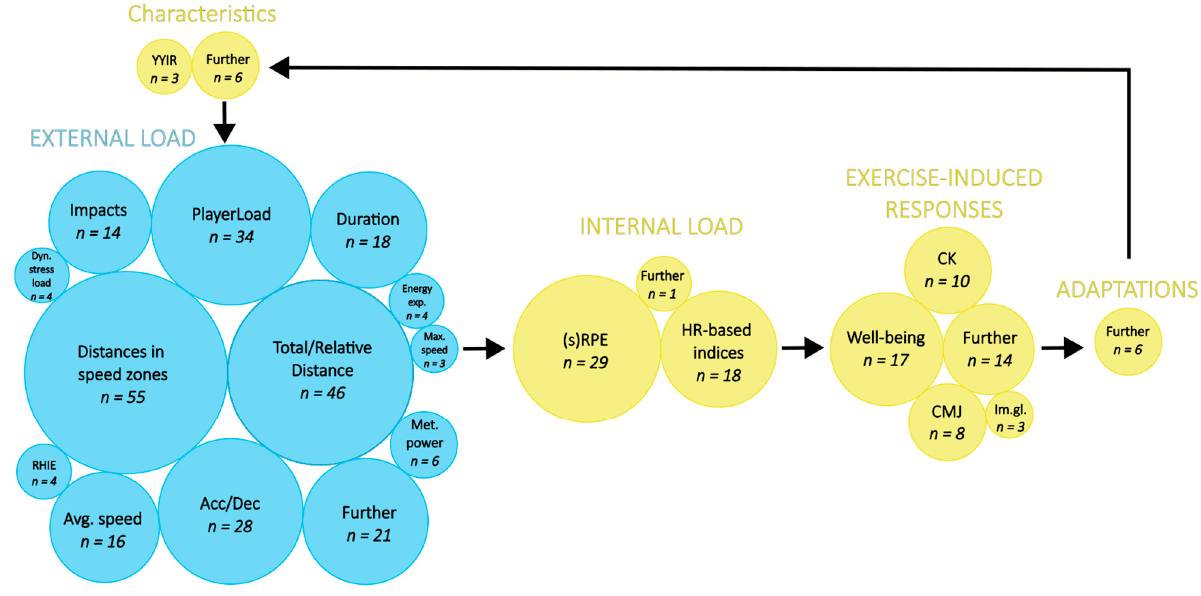
Figure 3. External and internal parameters with the number of studies they are appearing in. Parameters occurring in one or two studies only are pooled under “Further”. Acc/Dec, acceleration and deceleration parameters; Avg., average; CK, creatine kinase; CMJ, countermovement jump; Dyn., dynamic; exp., expenditure; HR, heart rate; Im.gl., immunoglobulin parameters; Max., maximal; Met., metabolic; RHIE, repeated high-intensity efforts; (s)RPE (session) rating of perceived exertion; Well-being, well-being questionnaires; YYIR, Yo-Yo intermittent recovery